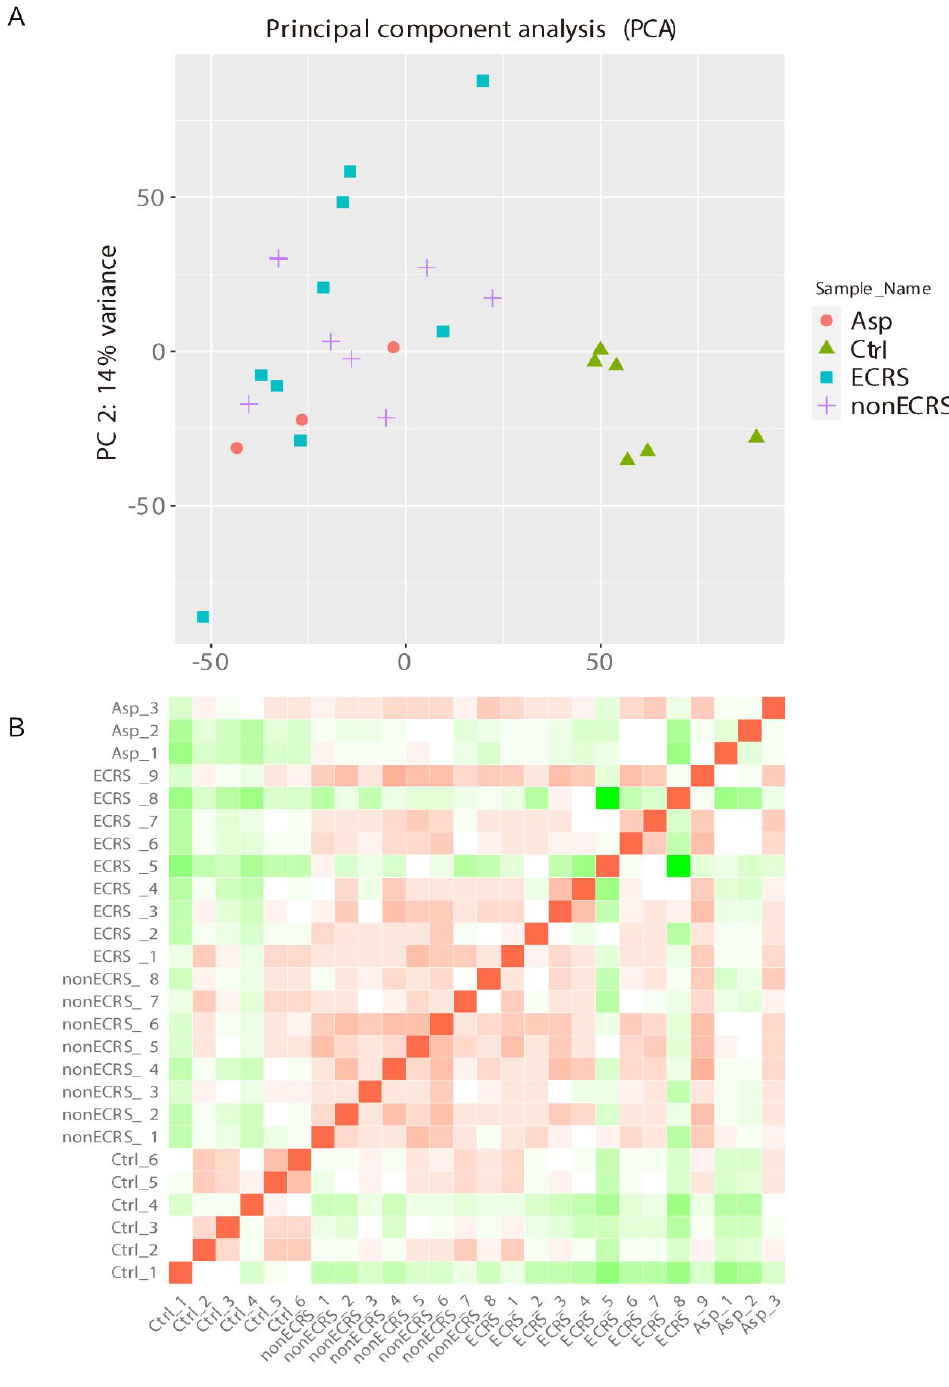
Figure 1. PCA and heatmap of the correlation matrix performed among all groups. The control group was clearly segregated from the other groups. ECRS, nonECRS, and Asp were not segregated from each other ( A ). The heatmap of the correlation matrix also showed the difficulty of the segregation among the three CRSwNP groups ( B ).